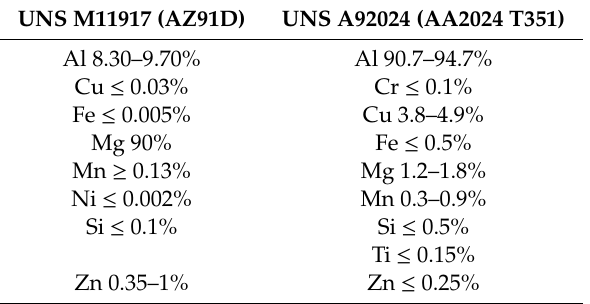
Table 3. Chemical composition of the materials used for the manufacturing specimens of UNS